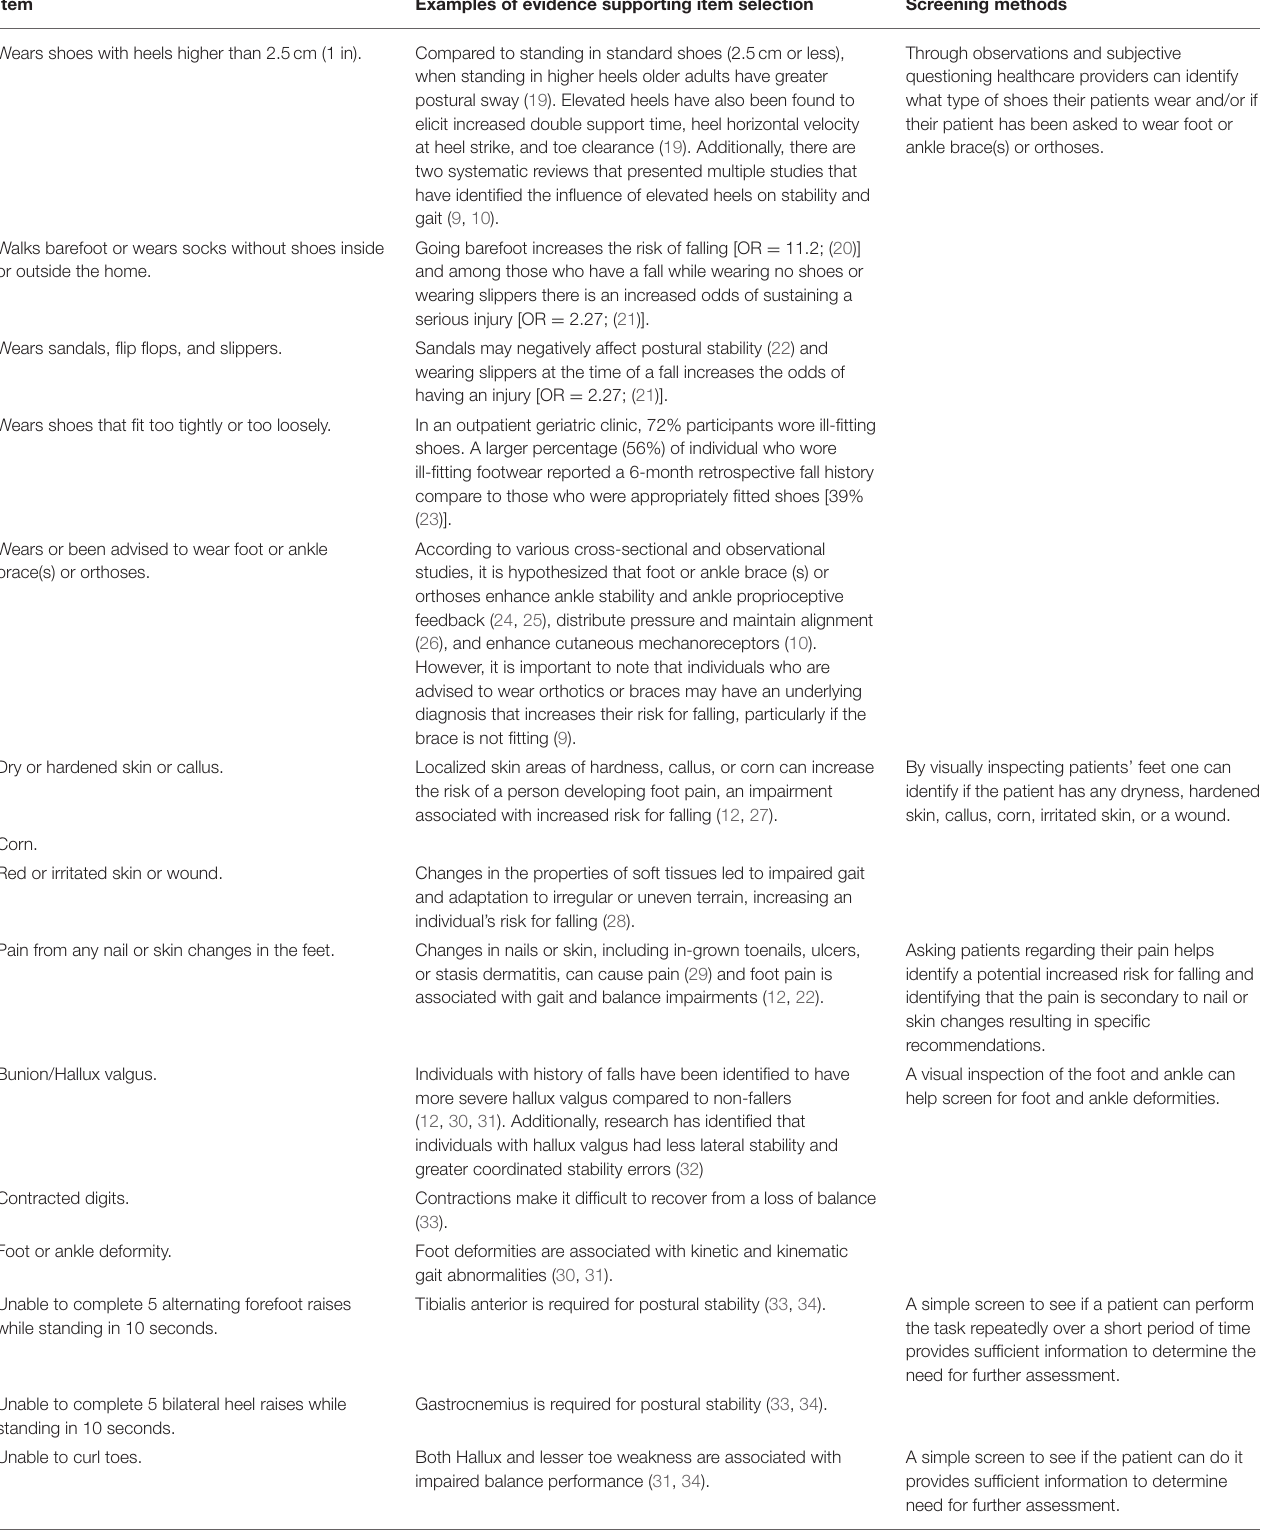
TABLE 1 | The screening tool’s items, examples of evidence supporting items and fall risk, and screening